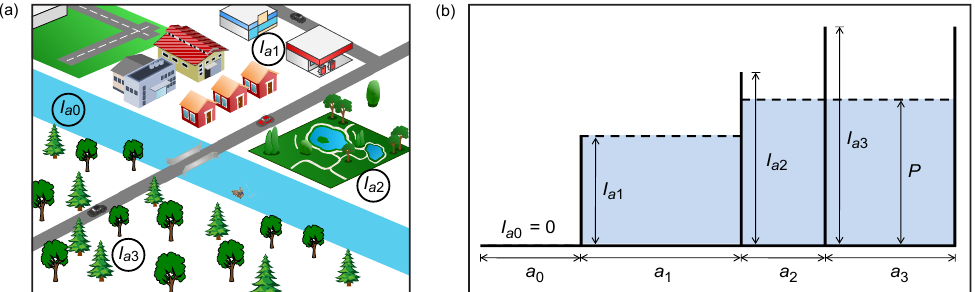
Figure 3. Spatial distribution of I a in a heterogeneous watershed. (a) I a i values of various HRUs mainly characterized by their land use types ( I a0 = 0 <I a1 <I a2 <I a3 ); (b) conceptual model in which each HRU is represented by a bin with height = I a i , width = a i , and unit thickness; shaded area indicates the filled portion during an event with rainfall = P